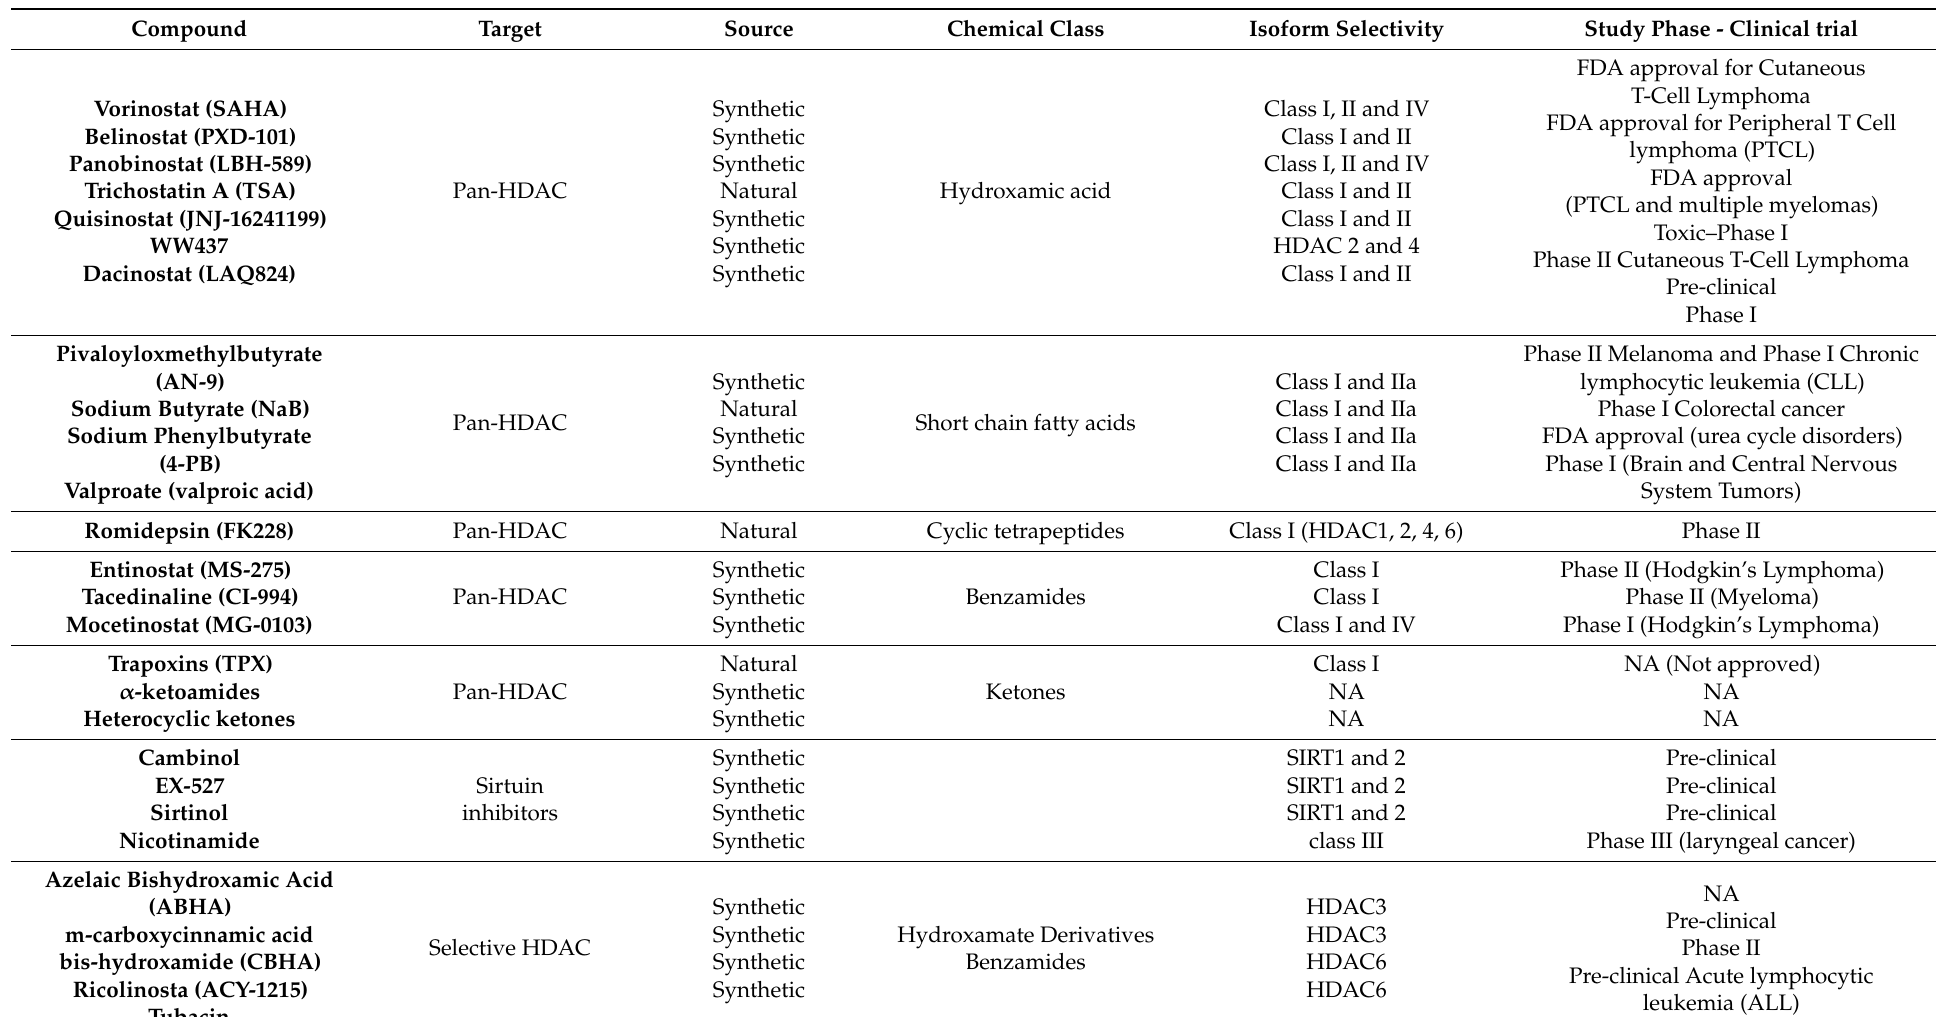
Table 1. Properties of HDAC inhibitors in clinical